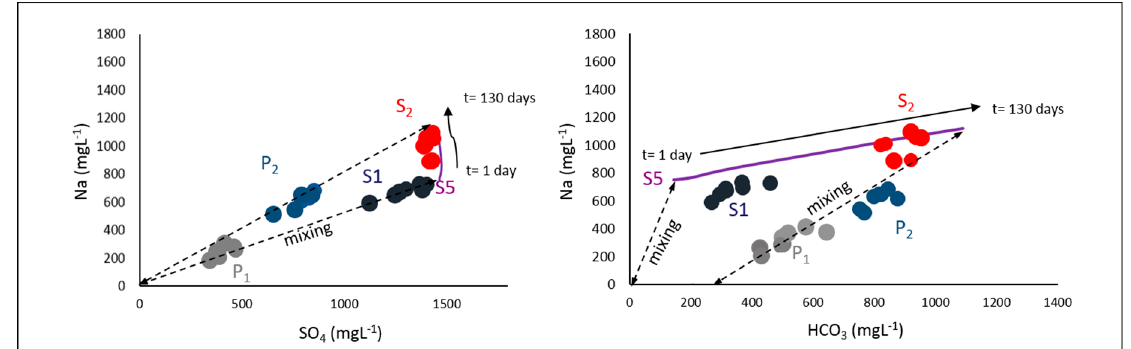
Figure 7. Na-SO 4 (on the left) and Na-HCO 3 (on the right) results of the kinetic modelling (purple dots) for interaction between rainwater and the soil sample S5, compared with groundwater monitoring P1, P2, S1 and